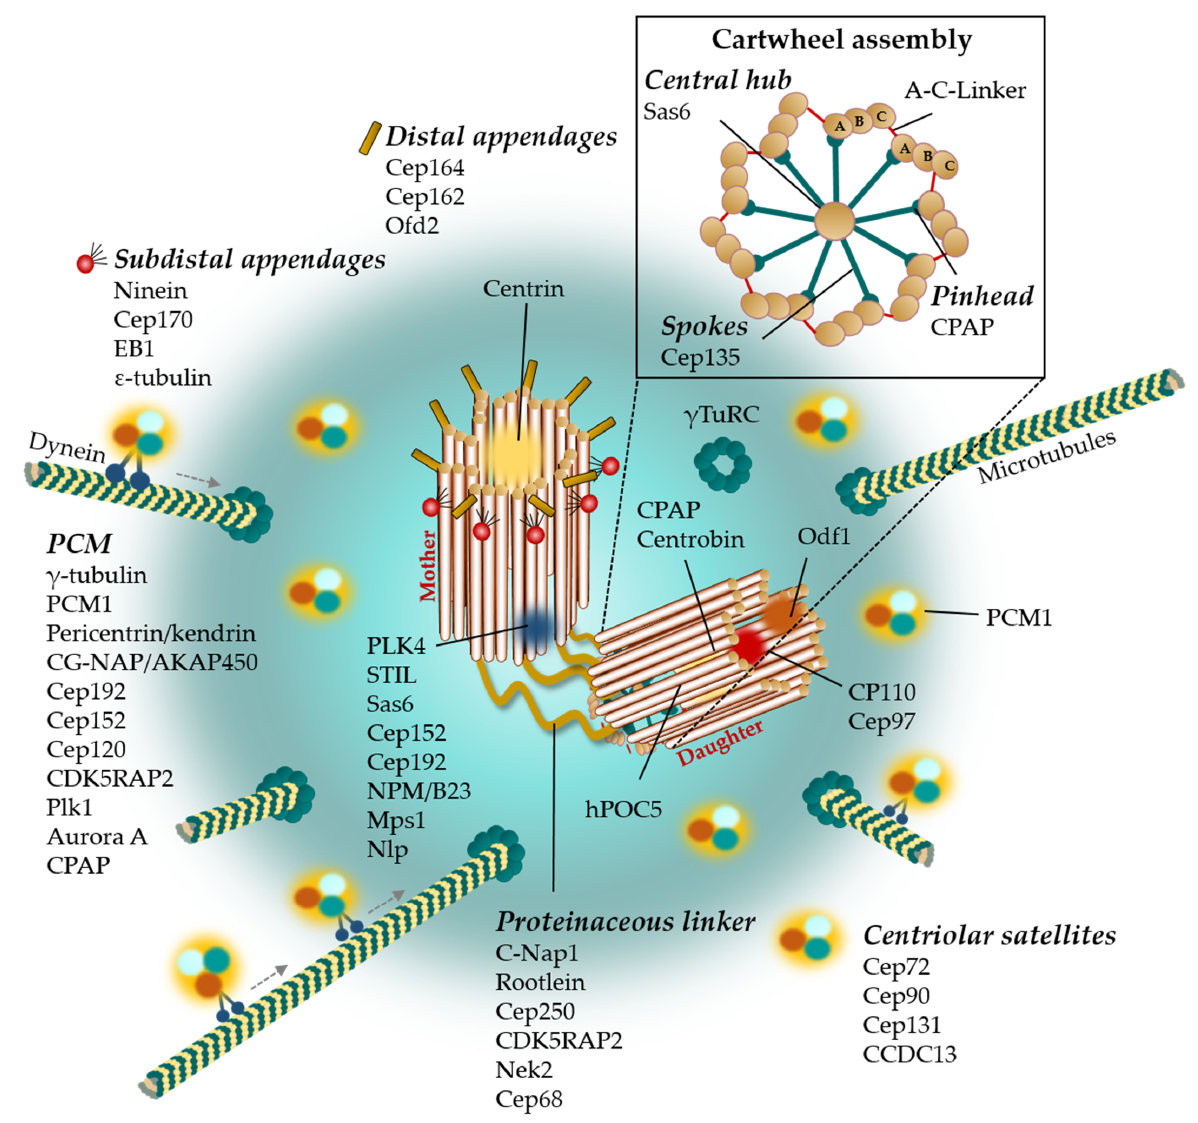
Figure 1. Mammalian Centrosome Architecture. The Centrosome consists of two orthogonal centrioles, embedded in the pericentriolar material (PCM) and is surrounded by small electron-dense granules (i.e., centriolar satellites). Centriolar satellites and PCM proteins are recruited towards the centrosome for centriole and microtubule assembly. Spindle microtubules are nucleated from γ -tubulin ring complexes ( γ -TuRCs). The mother centriole is characterized by its sub-distal and distal appendages, whereas the daughter centriole contains a characteristic cartwheel structure. The cen- triolar wall consists of microtubule triplets of A-, B, and C-tubules.